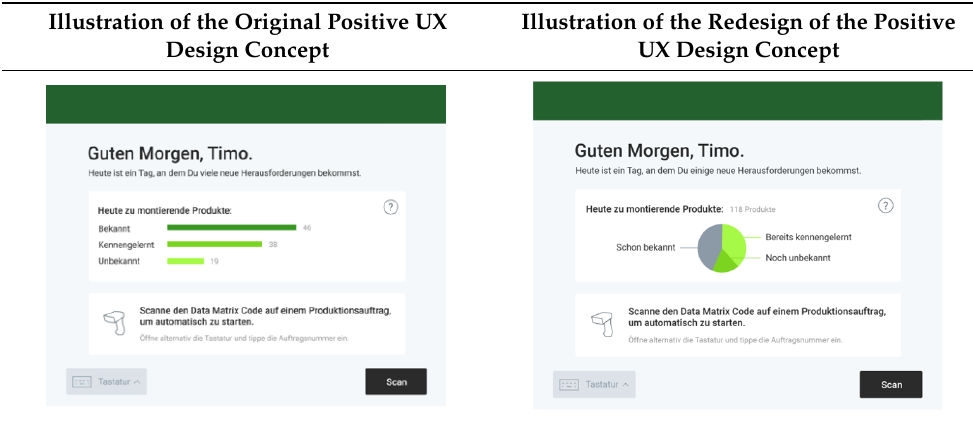
Table 4. Original positive UX design concept and respective redesign of “Daily preview”.